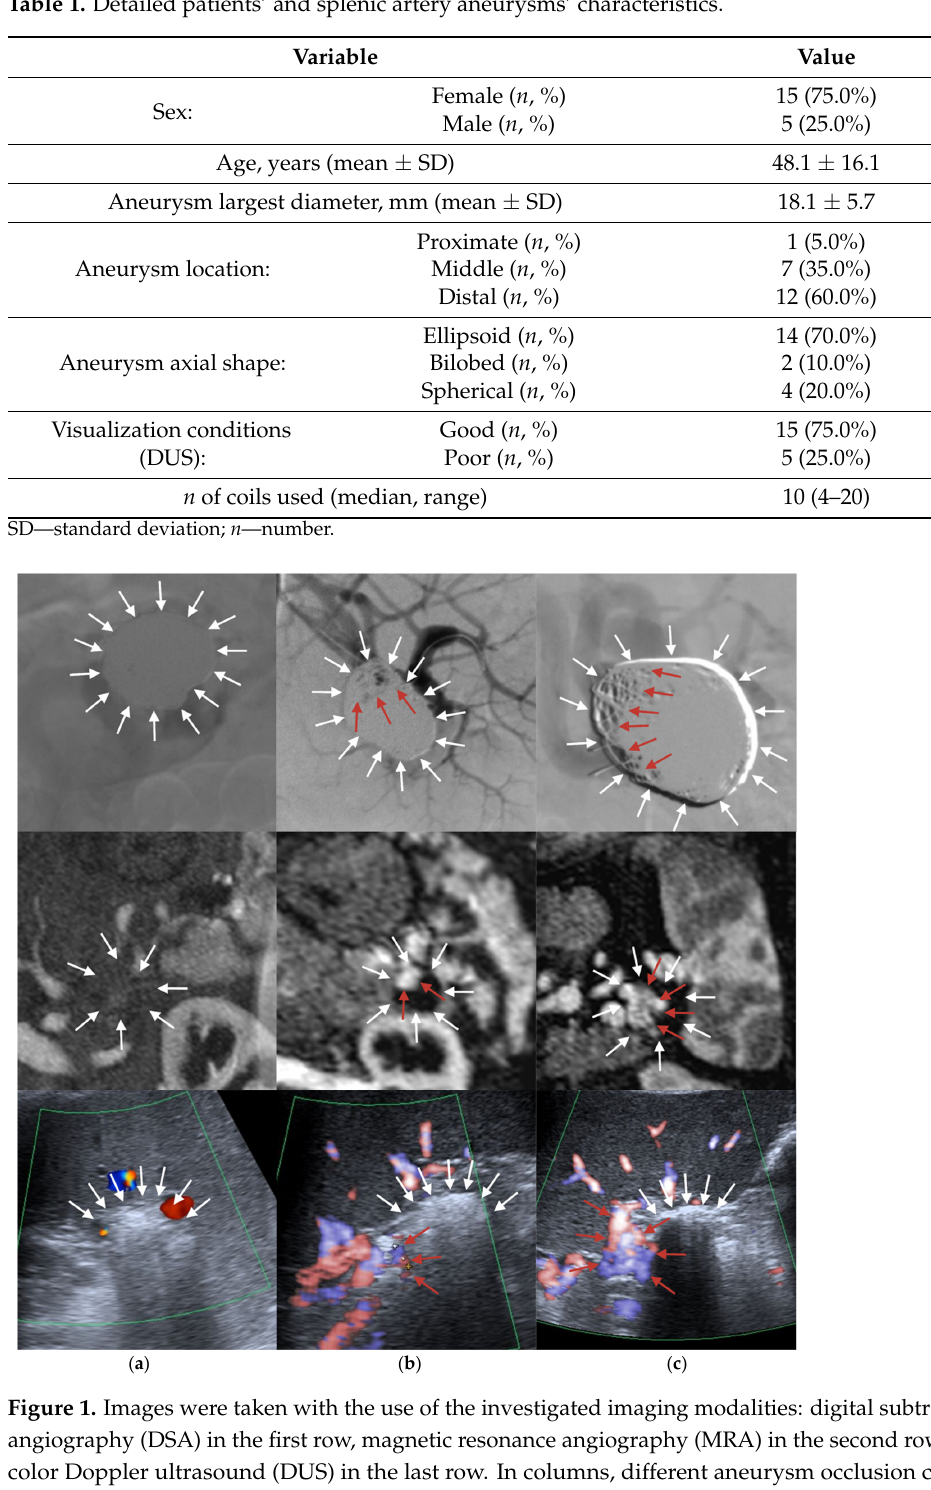
Table 2. Cross modality comparison between DUS and DSA in diagnosing aneurysm reperfusion.